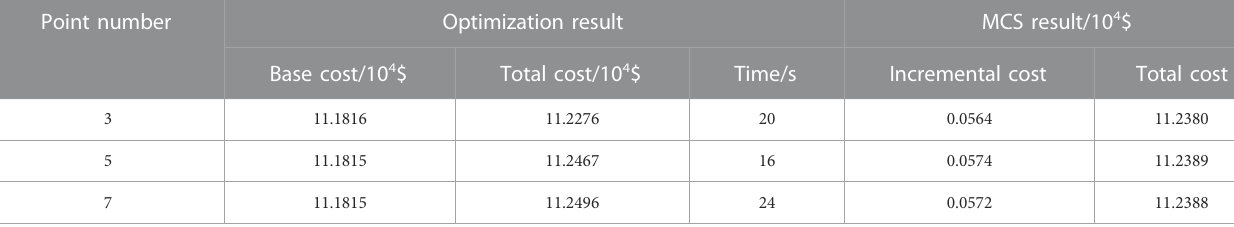
TABLE 4 Optimization and MCS results with different point numbers.